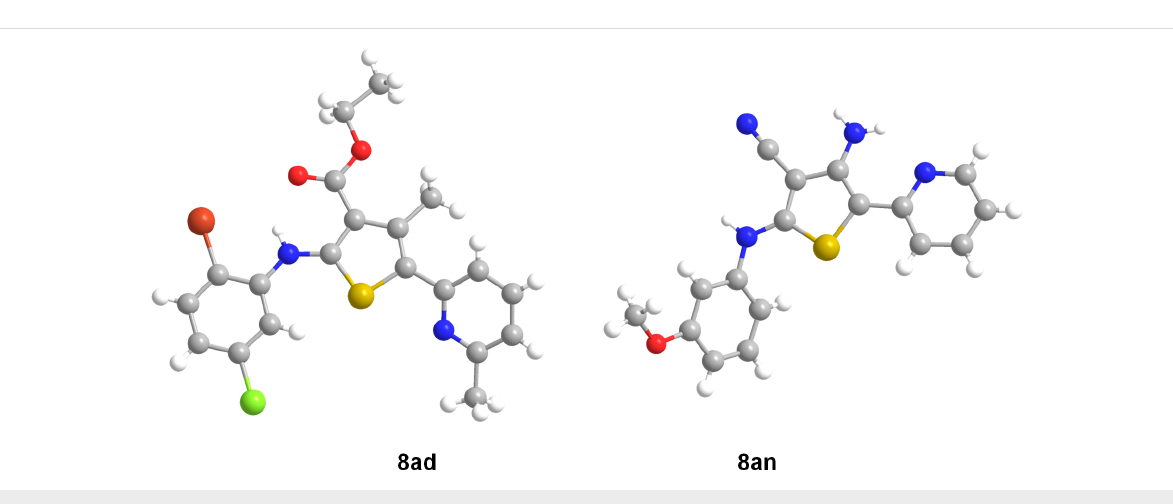
Figure 3: X-ray crystal structures of 8ad and 8an